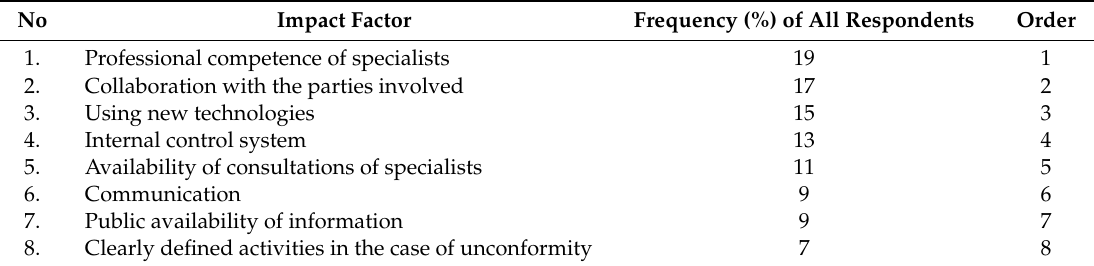
Table 3. The most frequent impact factors influencing positively the achievement of sustainability in the supervision